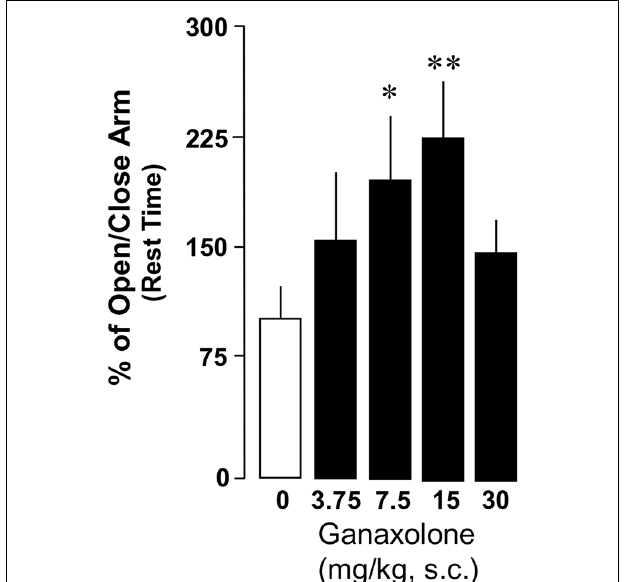
FIGURE 4 | Ganaxolone dose-dependently decreases social isolation-induced anxiety-like behavior of mice exposed to an elevated plus maze, determined by the ratios of open arm to closed arm rest time. Data represent the mean ± SEM of 8–14 mice. * P < 0.05; ** P < 0.01 when compared with vehicle-treated (0) mice.